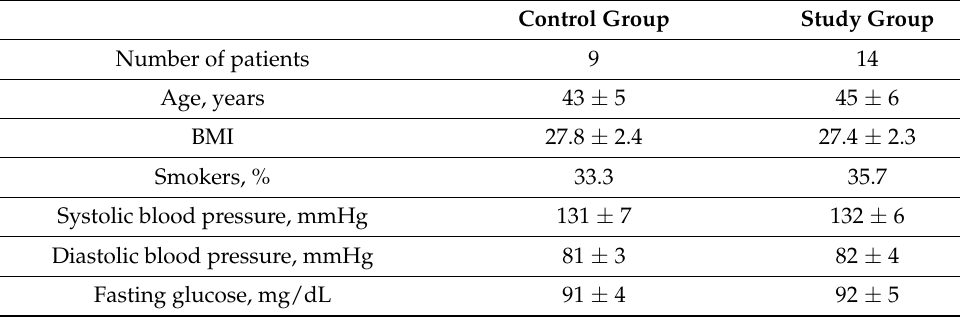
Table 1. Baseline characteristics of patients (values are mean ±